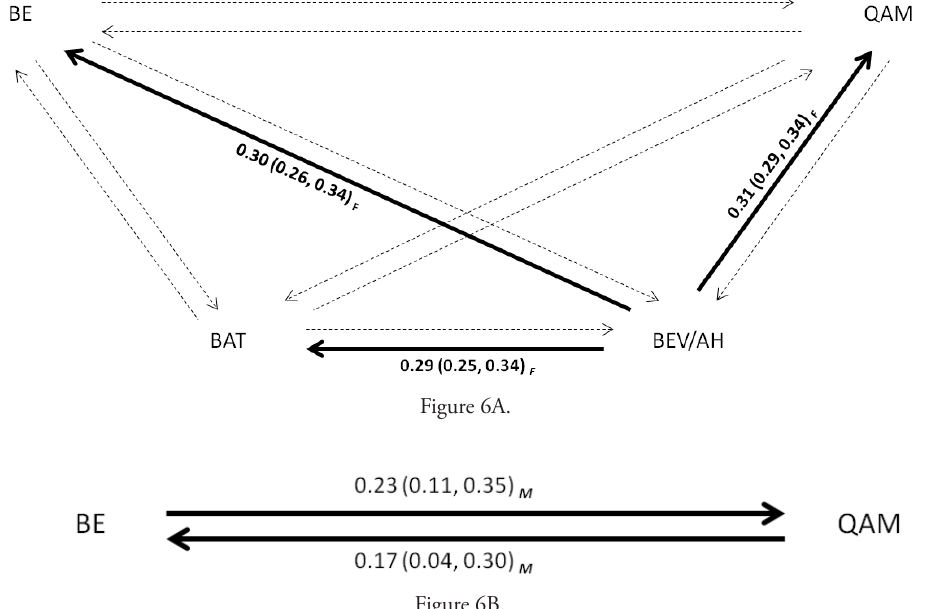
Figure 6. Contemporary gene flow rates between individual mainland subpopulations. Values indicate the proportion of migrants (m) from each subpopulation. 95% confidence intervals are in parentheses. Dashed arrows indicate values that did not significantly differ from zero based on 95% confidence intervals (all non-significant values were measured to be m = 0.01, with 95% confidence intervals that fell within -0.01, 0.04). A) Females-only. All female migrants were first-generation migrants. B) Males-only. Male migrants were a mixture of first- and second-generation migrants. Male gene flow into and out of BAT and BEV/AH was not examined because male samples were not available for